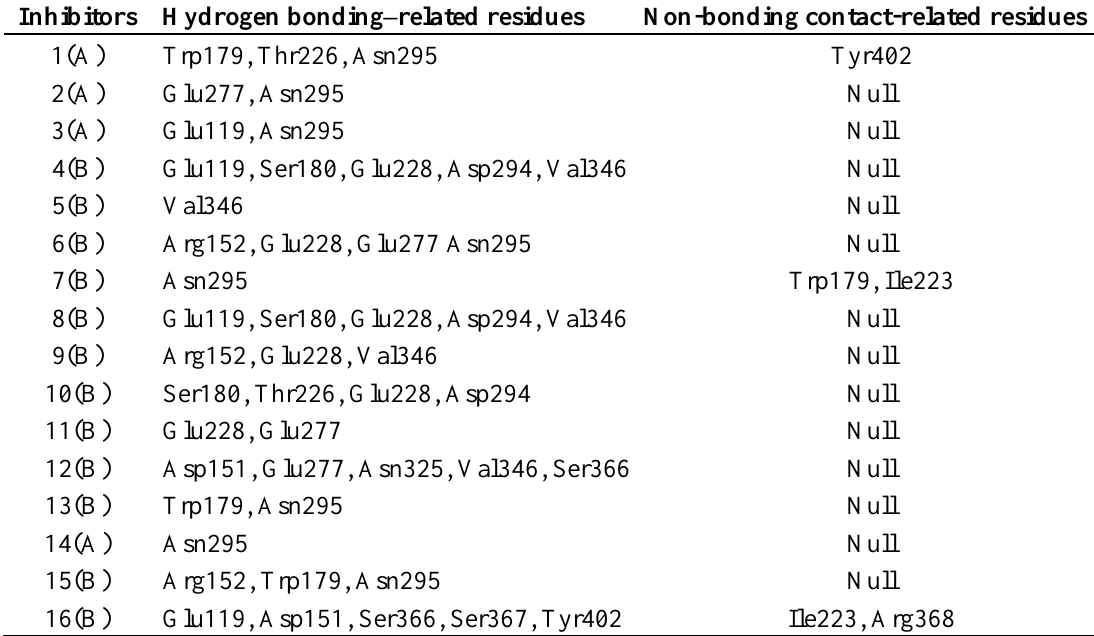
Table 1. Important results: Important residues of the 2009 H1N1 neuraminidase from the molecular docking and molecular dynamics (MD)